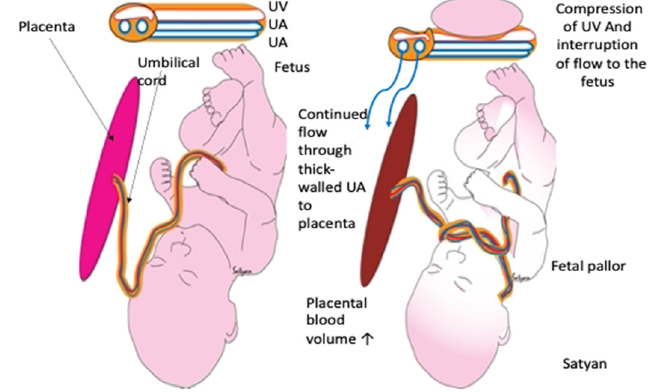
Figure 5. Effects of umbilical cord occlusion on the umbilical vein (UV) and umbilical arteries UA), placenta, and neonate. A shows no occlusion; B shows compression of the umbilical vein and interference with the flow from placenta to infant. Copyright by Satyan Lakshimrusimha, MD. Sacramento, CA, USA. Used with permission.